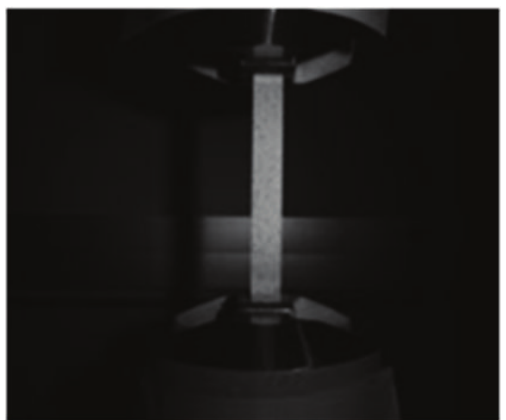
Figure 2: Tensile sample with DIC speckle pattern setup in the MTS